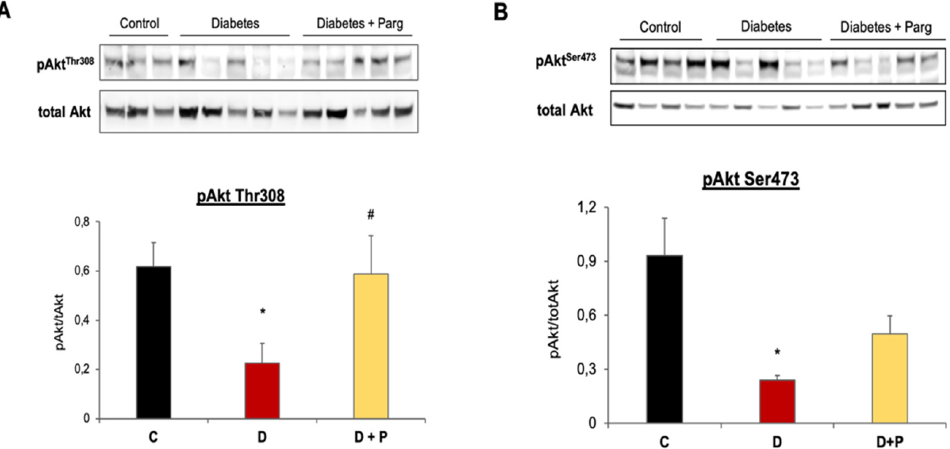
Figure 7. Effect of MAO inhibition on AKT activation in diabetic hearts. ( A ) Representative Western blot (upper panel) and densitometry analyses (lower panel) of the AKT phosphorylated on Thr 308 and total AKT are shown in control (C), diabetic (D) and diabetic mice treated with the MAO inhib- itor pargyline (D + P). Values were normalized to total AKT levels. * p ≤ 0.05 vs. C, # p ≤ 0.05 vs. D, with one-tailed equal variance t -test. ( B ) Representative Western blot (upper panel) and densitom- etry analyses (lower panel) of the AKT phosphorylated on Ser 473 and total AKT are shown in control (C), diabetic (D) and diabetic mice treated with the MAO inhibitor pargyline (D + P). Values were normalized to total AKT levels. * p ≤ 0.05 vs. C, with one-tailed equal variance t -test. 4. Discussion This study shows that MAO activity in diabetic hearts leads to profound tran- scriptomic changes, affecting proteolytic and pro-survival pathways activation in T1D mice in vivo. We also showed that MAOs might act as a signal leading to autophagy acti- vation in diabetic conditions. Importantly, MAO activation in T1D hearts also targets the expression of different miRNAs, such as miR-133a-3p, -185-5p, -193a-3p, -193b-3p, -27a- 3p. Among these, we confirmed Igf1r mRNA as the target of miR-133a-3p, Mapk10 and Grb10 as targets of miR-193a-3p, and identified Inpp4a , Elk1 and Rps6ka2 mRNAs as targets